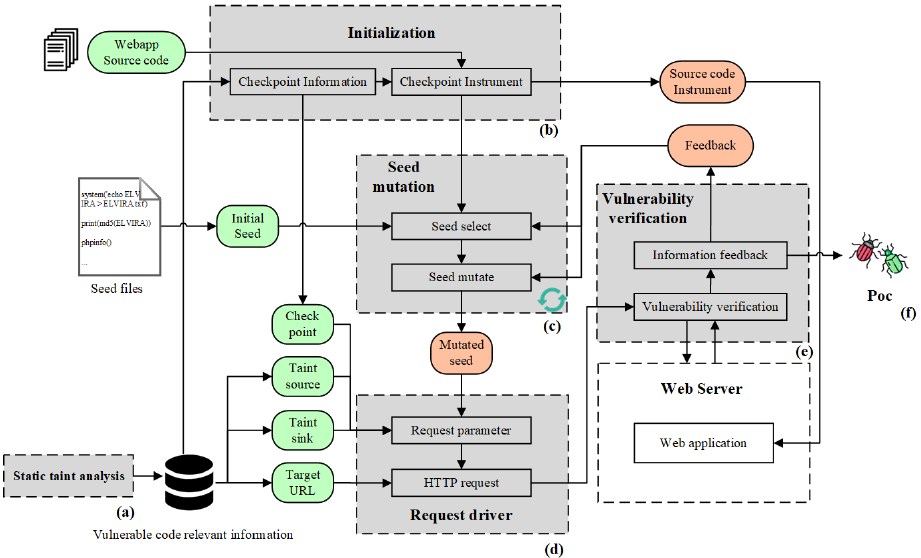
Figure 3 . The overview of our